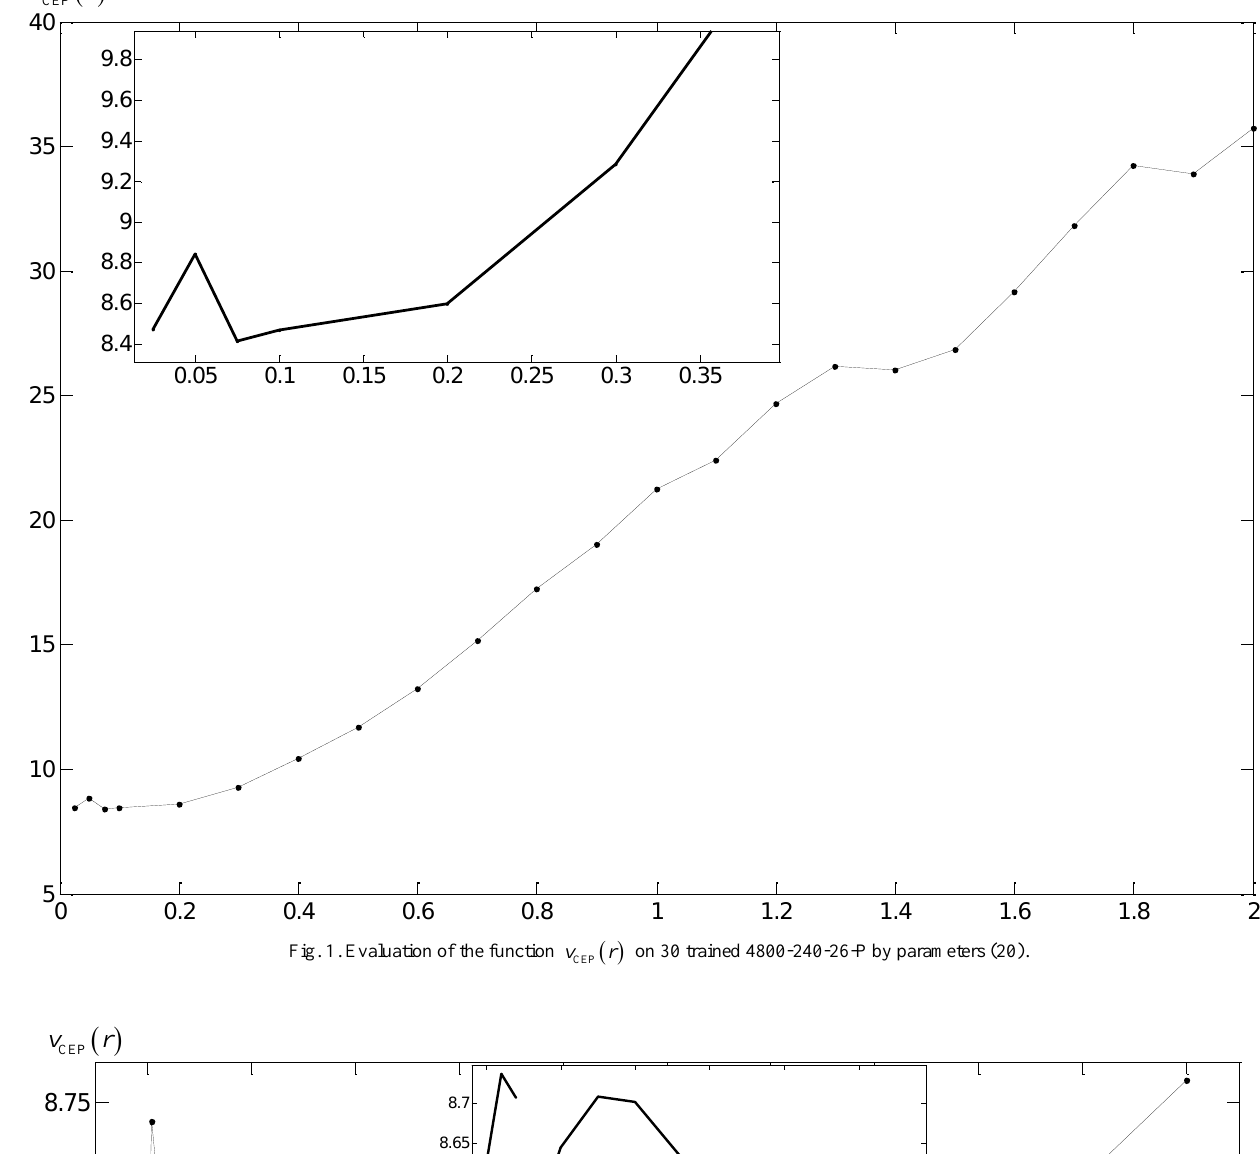
v r on 30 trained 4800-240-26-P by parameters (20). CEP